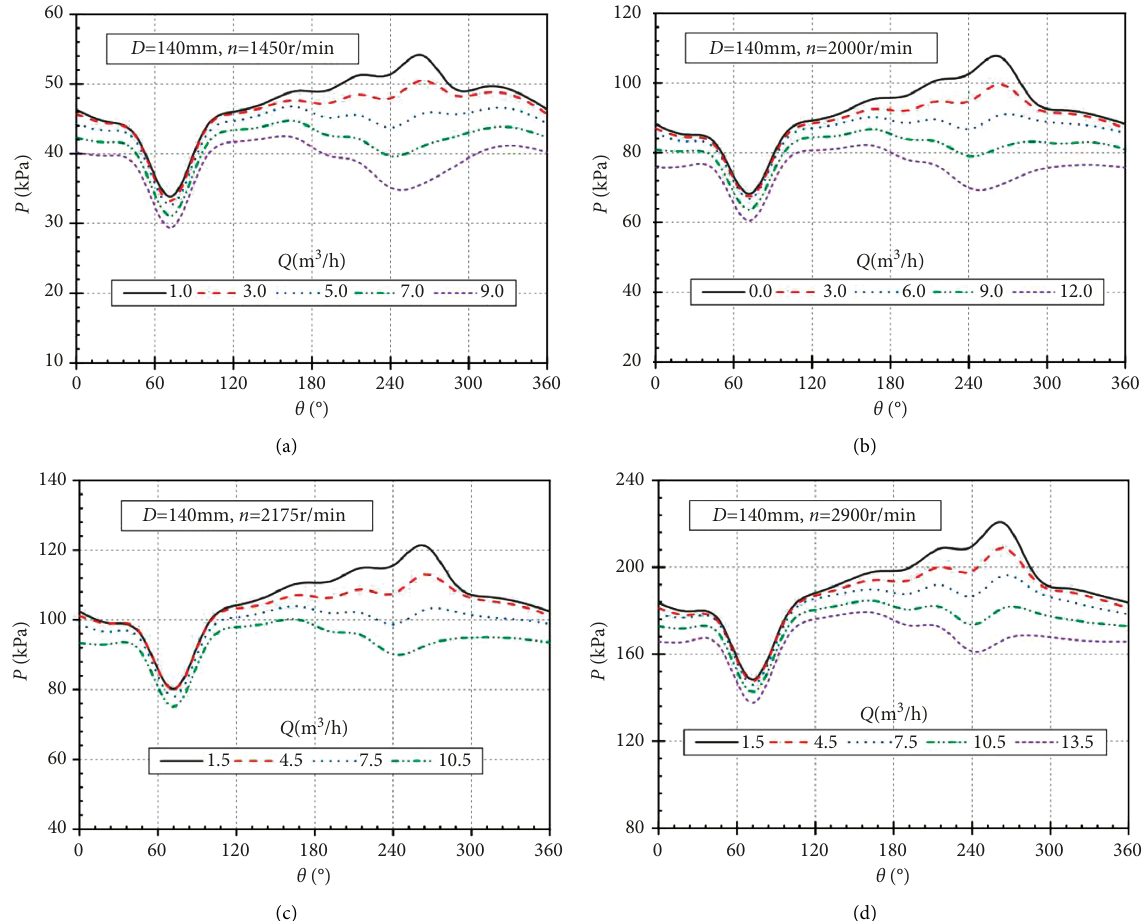
Figure 10: Average static pressure distribution at the front wall of volute casing ( D � 140